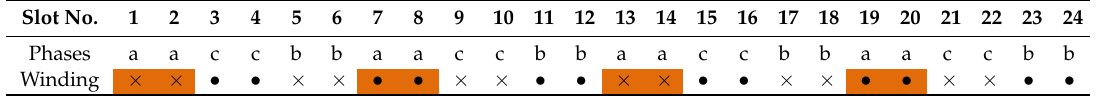
Table 1. Winding configuration for the T-PMSM.